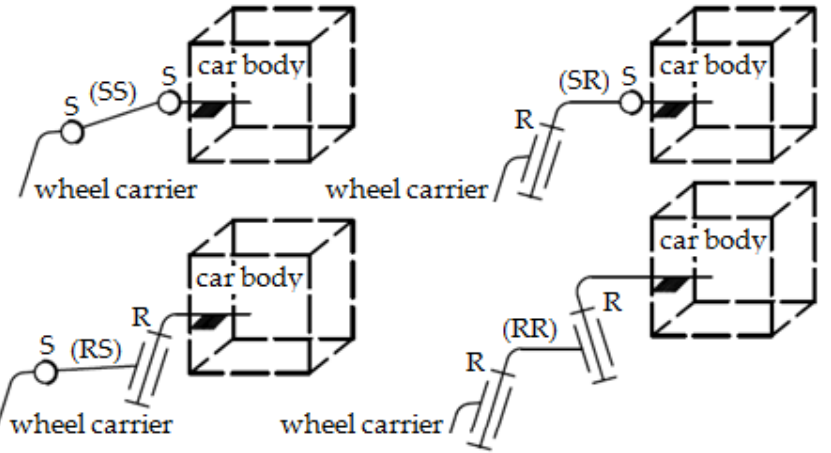
Figure 1. Basic binary chains for non-steered wheel guidance (S—spherical, R —revolute).